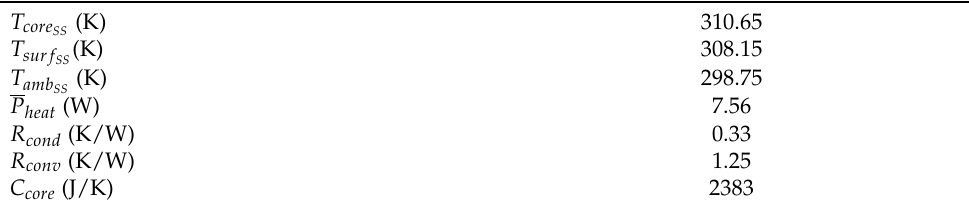
Table 4. Thermal characterisation results.